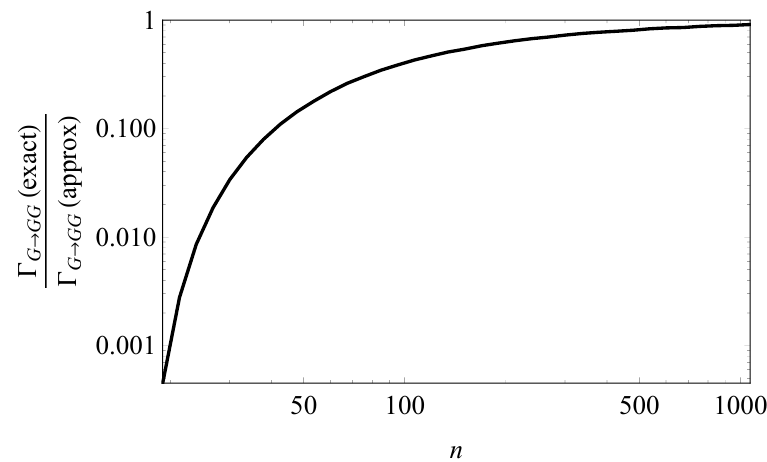
Figure 4 . Exact partial width of a mode- n KK graviton to pairs of lighter KK gravitons relative to the asymptotic expression given in eq. (2.48). Here we have taken M 5 = 10 TeV, k = 10 GeV, however the dependence on these parameters is